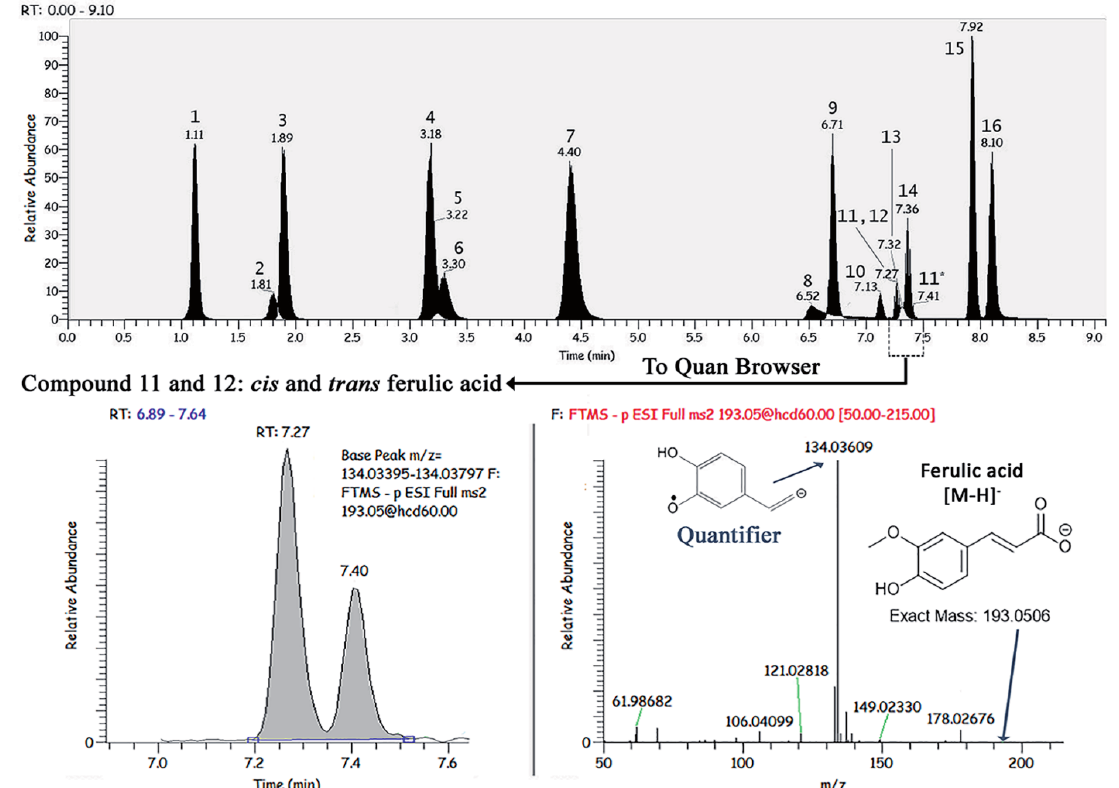
Fig. 3: LC-MS chromatogram of the quantified compounds in parallel reaction monitoring (PRM) mode. *Ferulic acid (Compound 11 ) appears in two peaks due to cis-trans